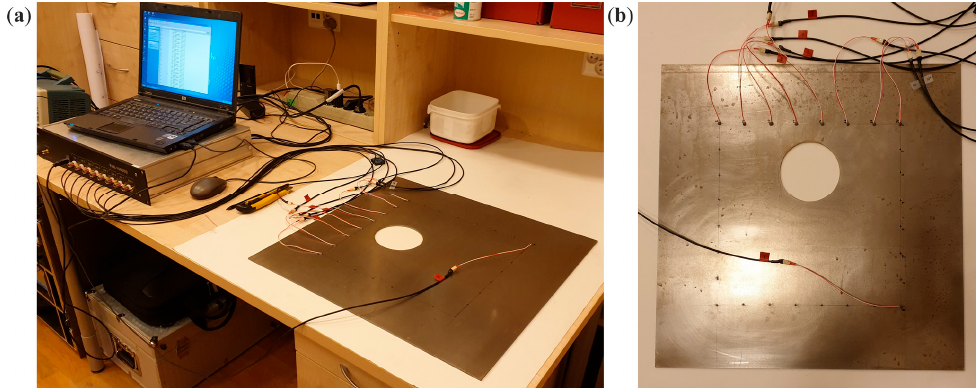
Figure 4. Experimental setup ( a ) and view on the steel plate with piezoelectric transducers ( b ).